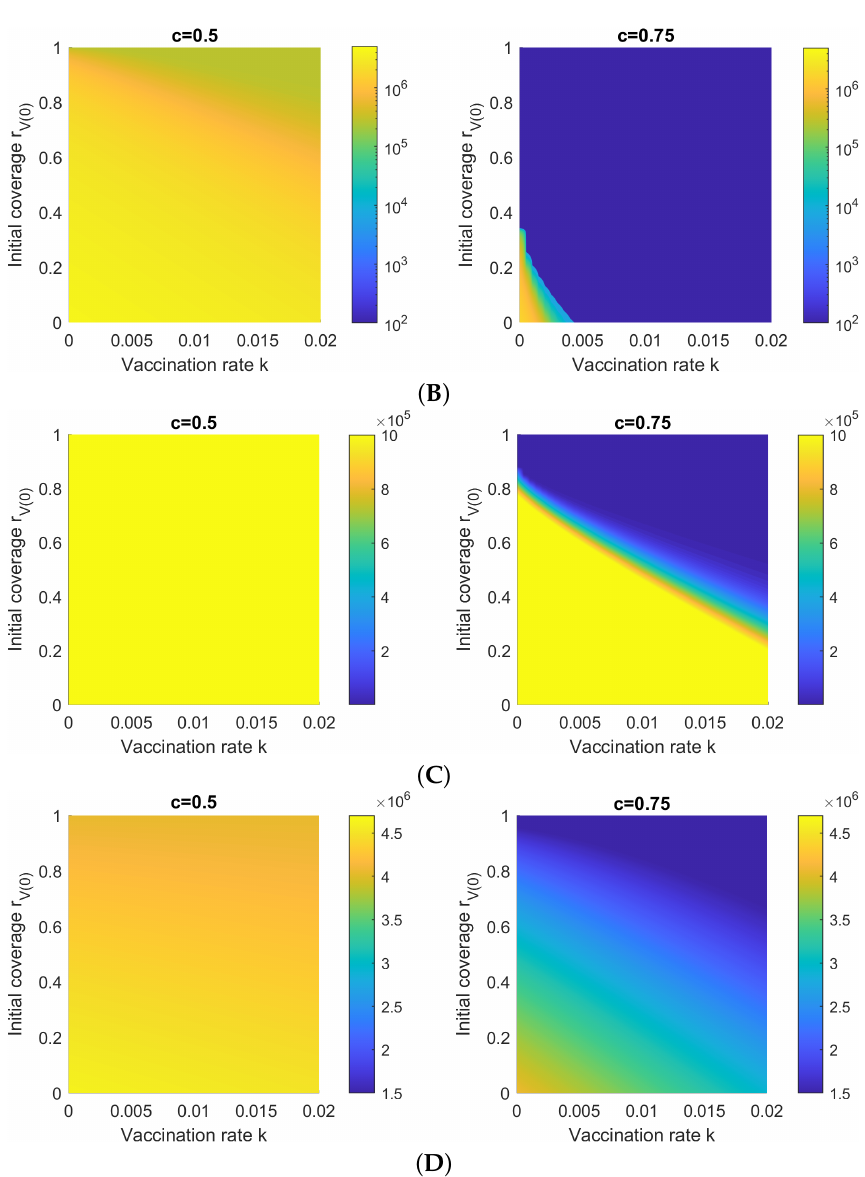
Figure 5. Cumulative hospitalizations/isolations H c ( ∞ ) with respect to initial vaccination cover- age r V ( 0 ) and vaccination rate k for ( A ) a simulated Delta outbreak with Comirnaty vaccinations, v e = 0.88; ( B ) a simulated Delta outbreak with CoronaVac vaccinations, v e = 0.59; ( C ) a simulated Omicron outbreak with Comirnaty vaccinations, v e = 0.655; and ( D ) a simulated Omicron outbreak with CoronaVac vaccinations, v e = 0.51. The results show that while Comirnaty can control a Delta outbreak without NPIs (if vaccination is high), only stringent NPI controls are able to limit the spread of Omicron, regardless of vaccination